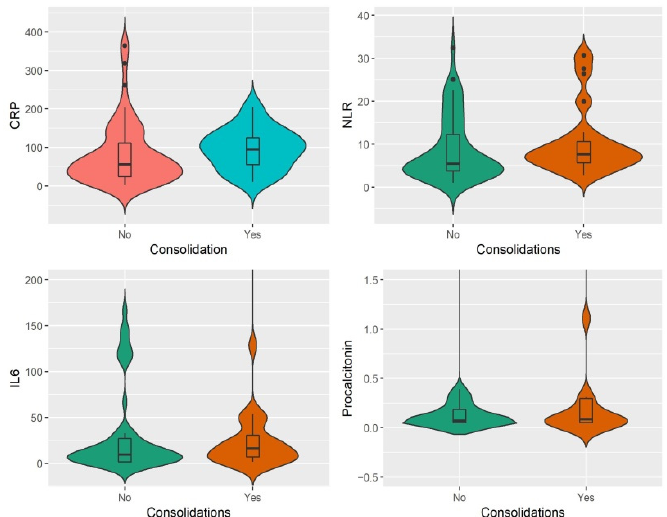
Figure 8. Difference between the medians of inflammatory markers according to CT presence of consolidations.